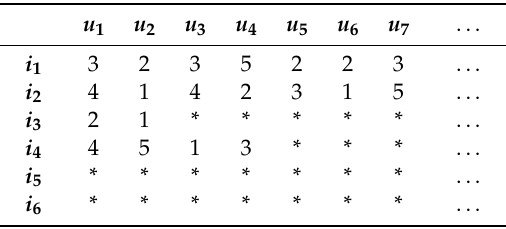
Table 1. Illustration of di ff erent types of items in